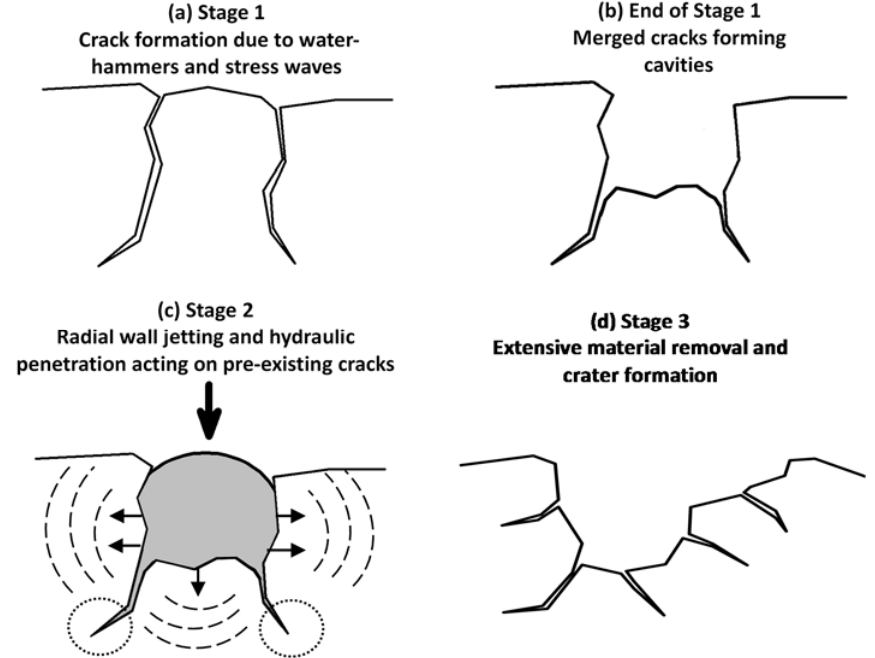
Figure 14. Schematic illustration of the material removal mechanism during LIE test. ( a ) Crack formation due to water-hammers and stress waves during Stage 1, ( b ) end of Stage 1 where cracks are merged and formed cavities, ( c ) radial wall jetting and hydraulic penetration representation in a pre-existing crack during Stage 2. The arrows represent the stress wave direction due to radial wall jetting, and the circles indicate the downward cracks propagation due to hydraulic penetration, ( d ) extensive material removal and crater formation in Stage